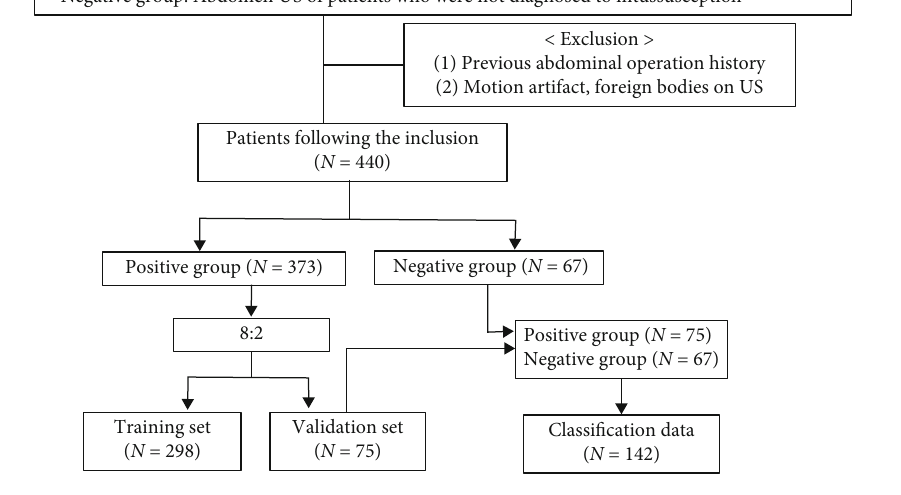
Figure 5: Flow chart of data collection.